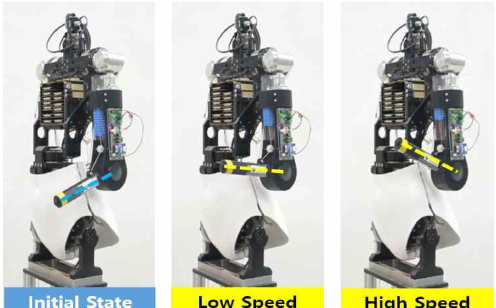
Figure 12. The actuator module is applied for elbow manipulation. The mass of the lower arm was M = 36.9 g, and Ω = 160 rev/s and Ω = 200 rev/s were applied for low speed and high speed manipulation,